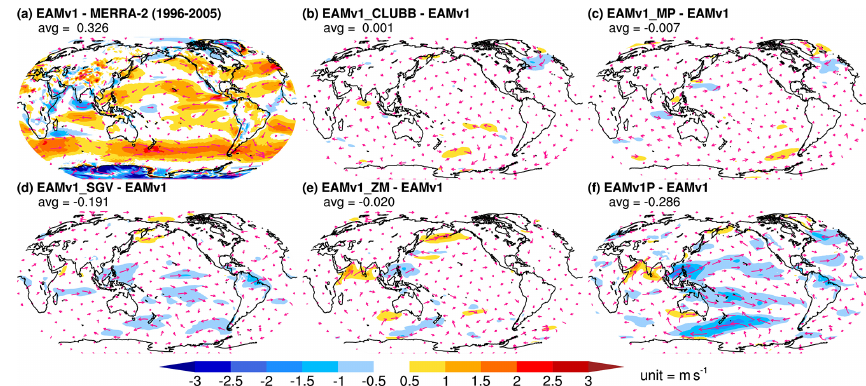
Figure 11. Winds at the lowest model level. The surface winds from the Modern-Era Retrospective Analysis for Research and Applications Version 2 (MERRA-2) (Gelaro et al., 2017) is used for the comparison with